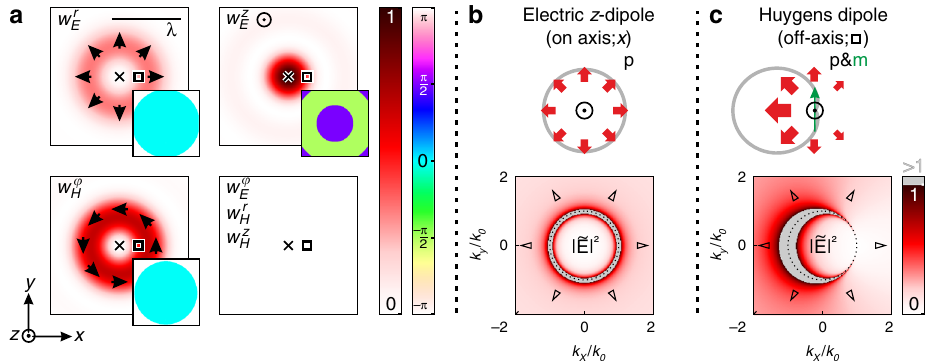
(cid:1) (cid:1) (cid:1) (cid:1) ¼ μ 0 H (cid:1) (cid:1) 2 ϕ H 4